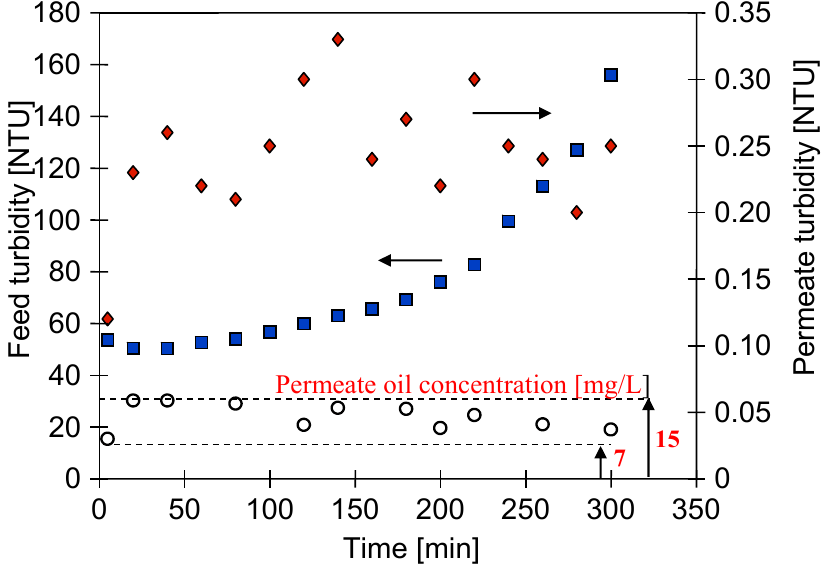
Figure 13. Changes in the feed and permeate turbidity, as well as permeate oil concentration, during the MF process of oily wastewater #1. Module MF1, TMP = 0.05 MPa, T = 22 °C, V F = 0.5 m/s.